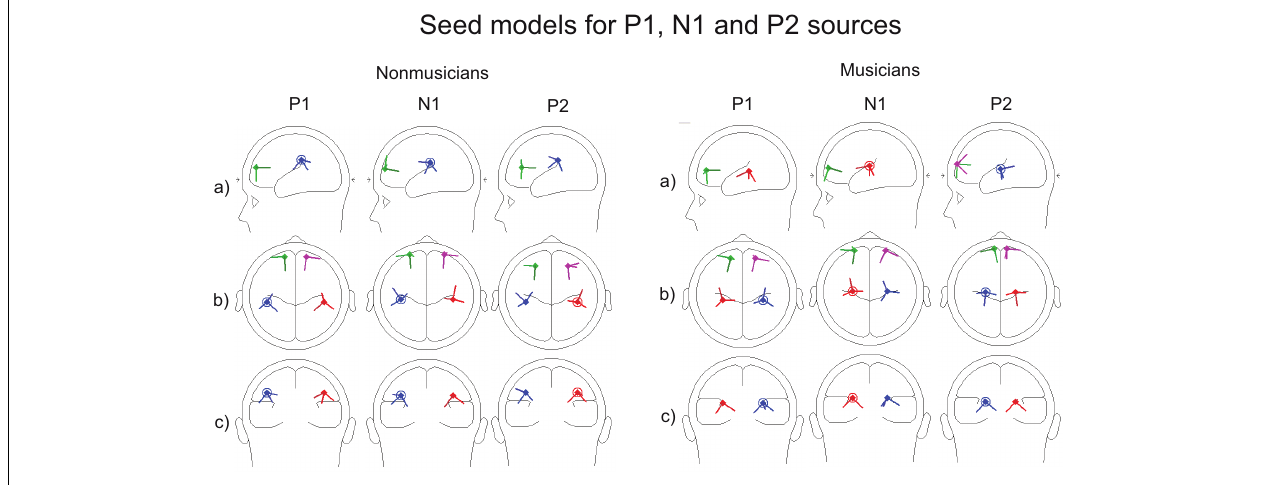
FIGURE 2 | Seed models of musicians and non-musicians for P1, N1, and P2 BESA source analysis. Sources are presented from the (A) sagittal, (B) vertical, and (C) coronal viewpoints.